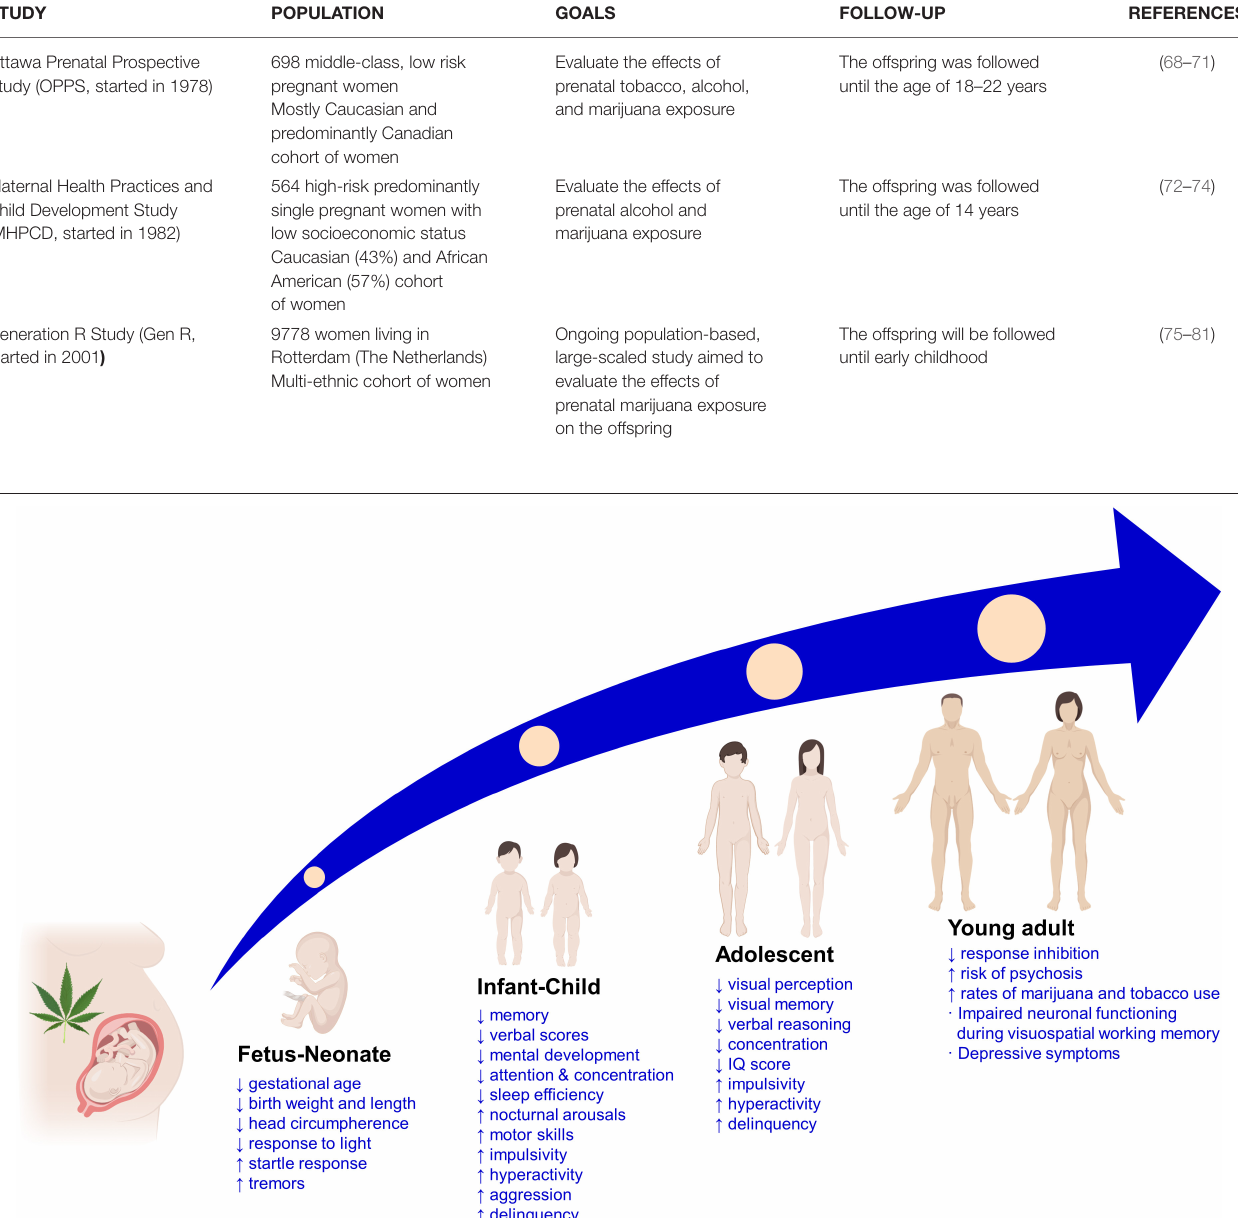
TABLE 1 | Summary of the main methodological aspects regarding the three most important longitudinal and prospective clinical studies evaluating the effect of perinatal cannabis exposure.